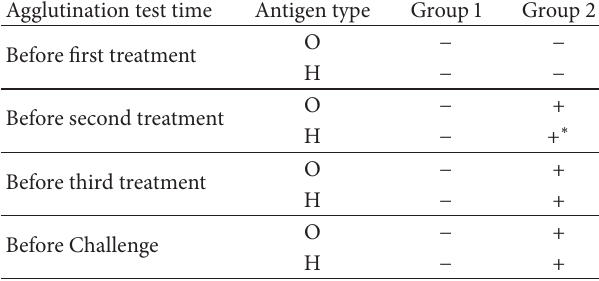
Table 2: Different agglutination results of the collected